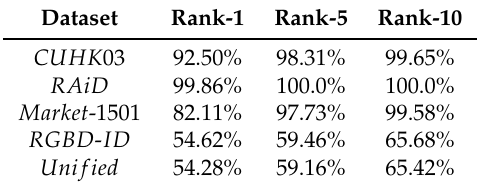
Table 2. Accuracy at different ranks, per dataset, as achieved by the Inception V3 network.